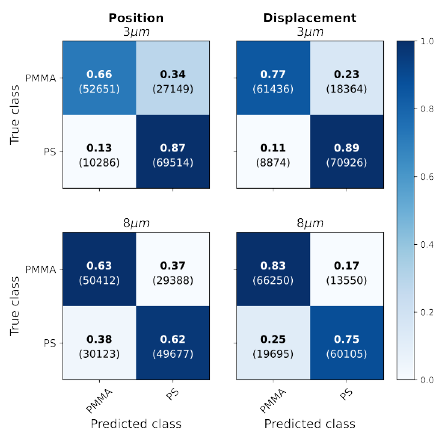
Figure 3. Size classification results between 3 µ m and 8 µ m of PMMA particles (top row) and 3 µ m , 4 µ m and 8 µ m PS particles (bottom row). Left column (right column) is position (displace- ment) based classification